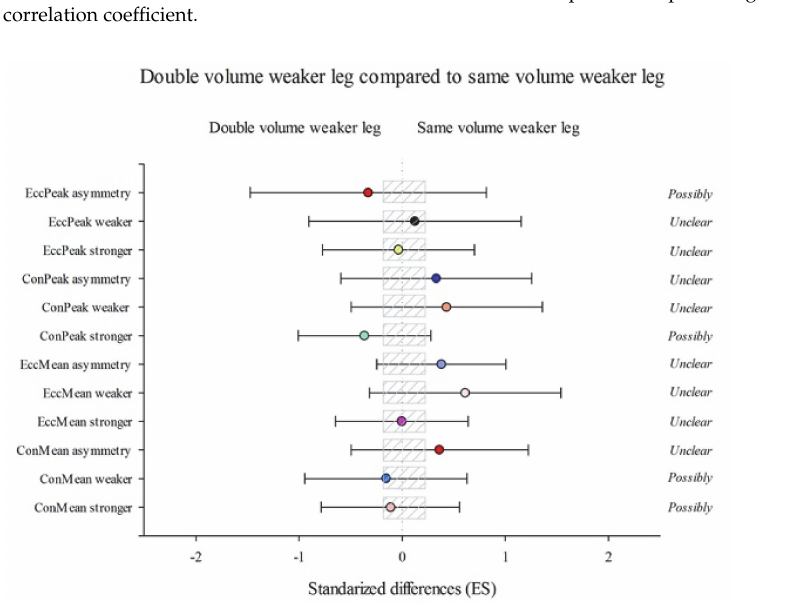
Figure 2. Efficiency of the unilateral eccentric overload training performing the double volume with the weaker leg starting with the weaker leg (DVW) compared with the unilateral eccentric overload training performing the same volume with both legs, starting with the weaker leg (SVW). Training program to improve a lateral squat in mean concentric power (ConMean) with the stronger and the weaker leg and the corresponding asymmetry; mean eccentric power (EccMean) with the stronger and the weaker leg and the corresponding asymmetry; maximum peak concentric power (ConPeak) with the stronger and the weaker leg and the corresponding asymmetry; maximum peak eccentric power (EccPeak), with the stronger and the weaker leg and the corresponding asymmetry. (Bars indicate uncertainty in the true mean changes with 90% confidence limits.) Trivial areas were the smallest worthwhile change (see Section